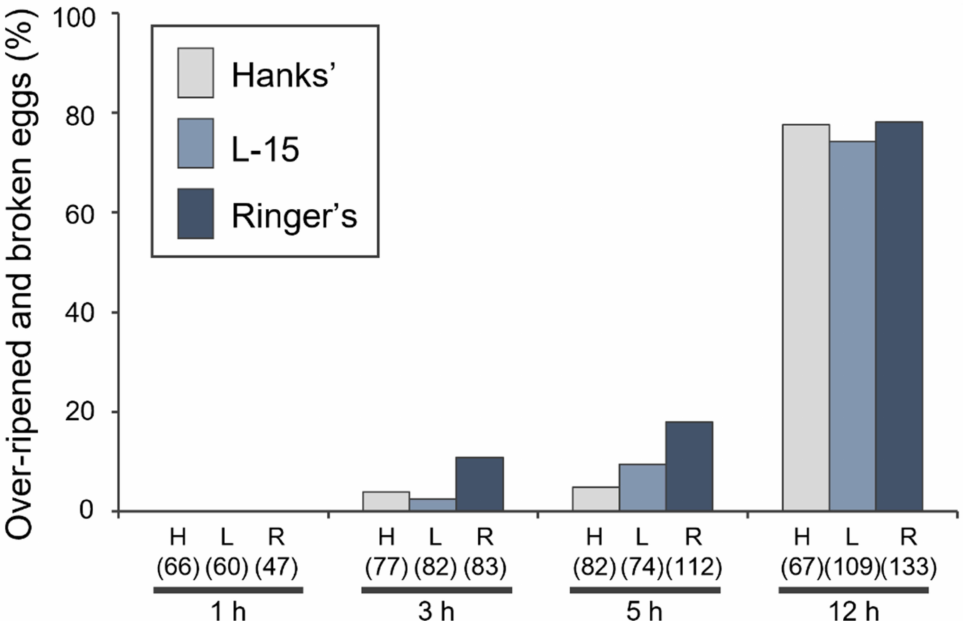
Figure 3. The rates of over-ripened and broken eggs of kawakawa Euthynnus affinis after preservation in different solutions. The rates of over-ripened and broken eggs during preservation were calculated after preservation of ovulated eggs in Hanks’ solution, L-15 medium, and Ringer’s solution for 0, 1, 3, 5, and 12 h at 20 ◦ C. The number of analyzed ovulated eggs is in brackets. Statistical analysis could not be carried out because each value is the total number of ovulated eggs from one